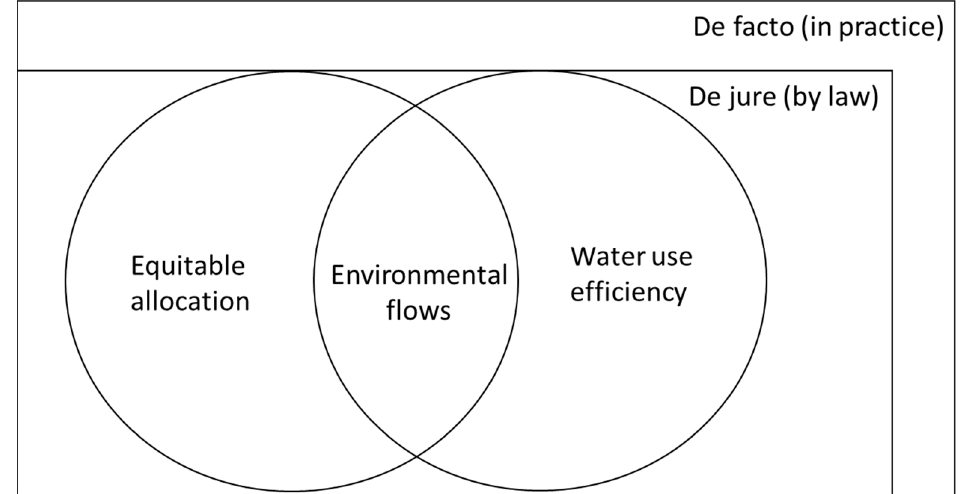
Figure 1. The method we used to evaluate mismatches in environmental flow governance in Puerto Rico. We identified two targets (equitable allocation and water use efficiency) in legislation and in practice.